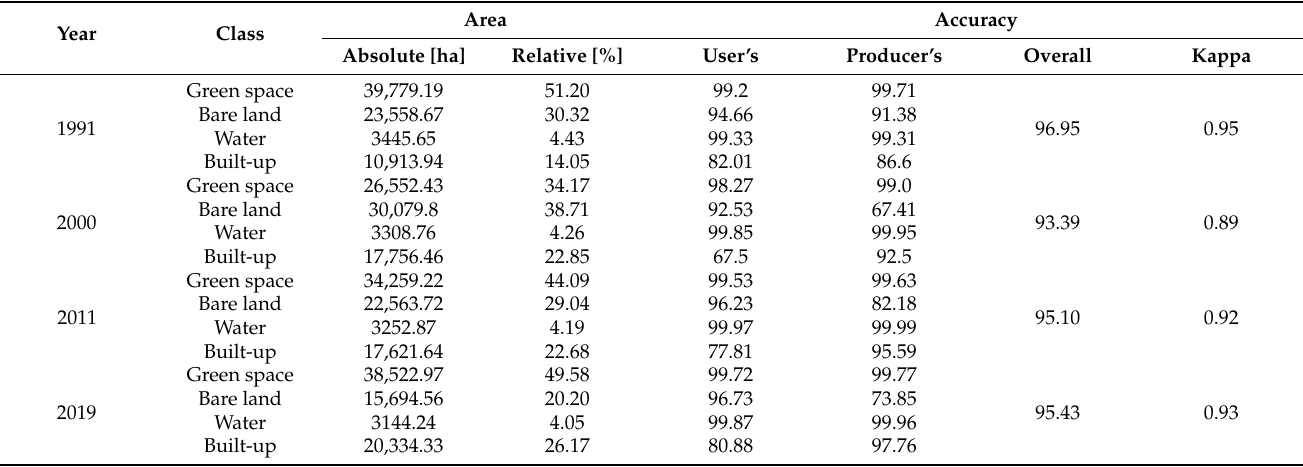
Figure 6. Land cover classification for 1991, 2000, 2011 and 2019. Table 3. Land cover class areas and accuracy assessment for 1991, 2000, 2011 and